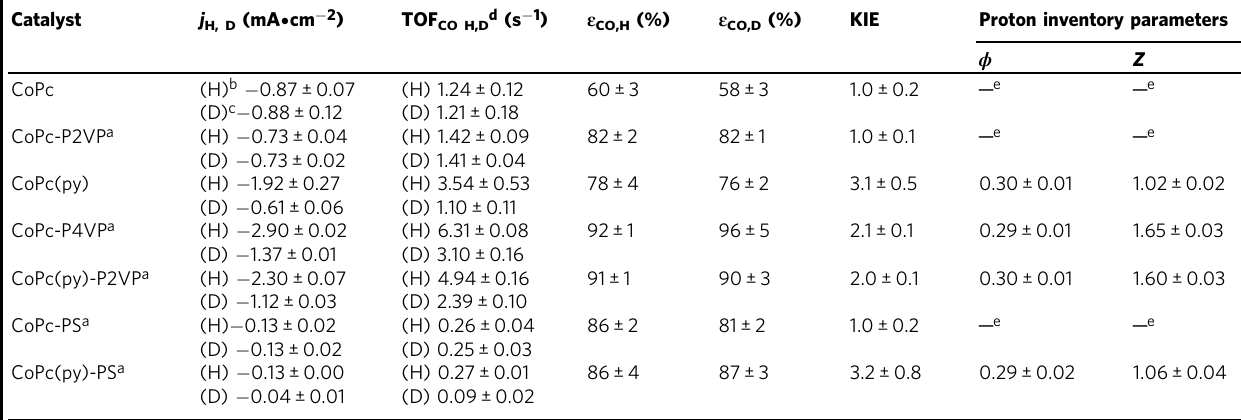
Table 1 Activity and Faradaic ef fi ciency ( ε ) measurements for catalysts in protic and deuterated solutions, and determined kinetic isotope effects